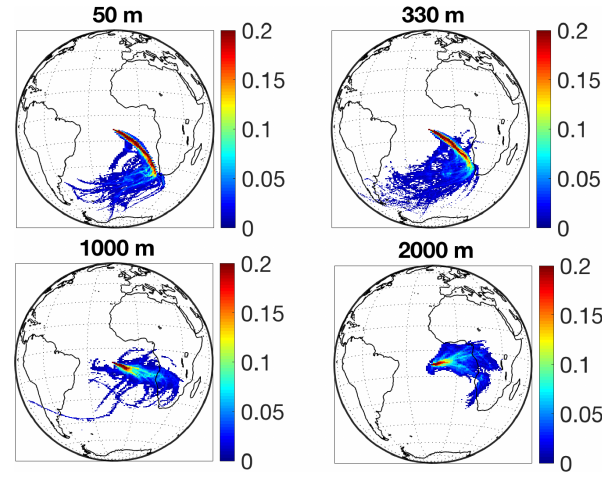
Figure 11. Trajectory density plots for starting heights 50, 330, 1000, and 2000m above sea level using HYSPLIT (Stein et al., 2015) 10d back trajectories, averaged over August 2017. There is one trajectory initiated each hour. The colour bar depicts the density of trajectories over each 0 . 5 ◦ × 1 ◦ latitude–longitude grid cell, with each grid cell having a minimum of five trajectories passing through it and displayed as a relative area weighted